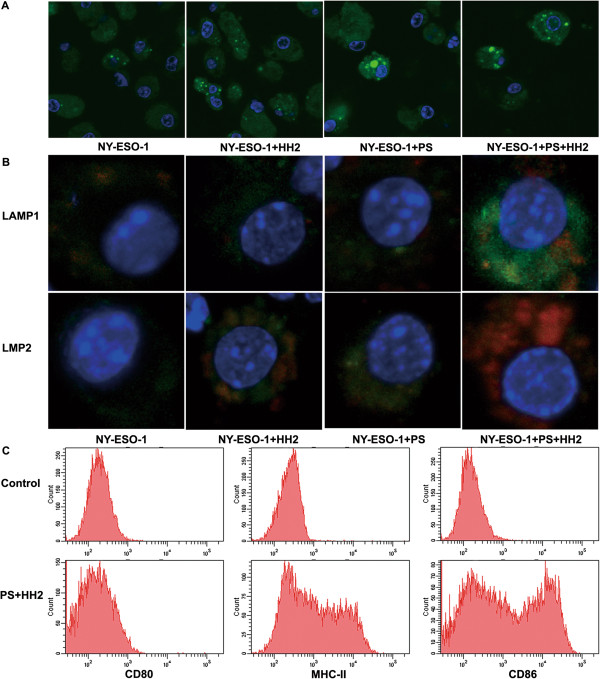
PS-HH2 complex adjuvant promotes the antigen uptake and cross -presentation and maturation of DCs. A, DC were incubated with NHS-conjugated native NY-ESO-1 or protein adjuvant complex for 3 h, fixed, stained with DAPI and analyzed via confocal laser microscopy. B, DCs were incubated with Alexa Fluor-labeled NY-ESO-1 or NY-ESO-1/complex adjuvant for 3 h, fixed, permeabilized, blocked and stained with mouse FITC-anti-LAMP1 or FITC-anti-LMP2 antibody, respectively. DNA was stained with DAPI and analyzed via confocal laser microscopy. C, Analysis of surface maturation markers of DCs stimulated with PS-HH2 for 24 h.